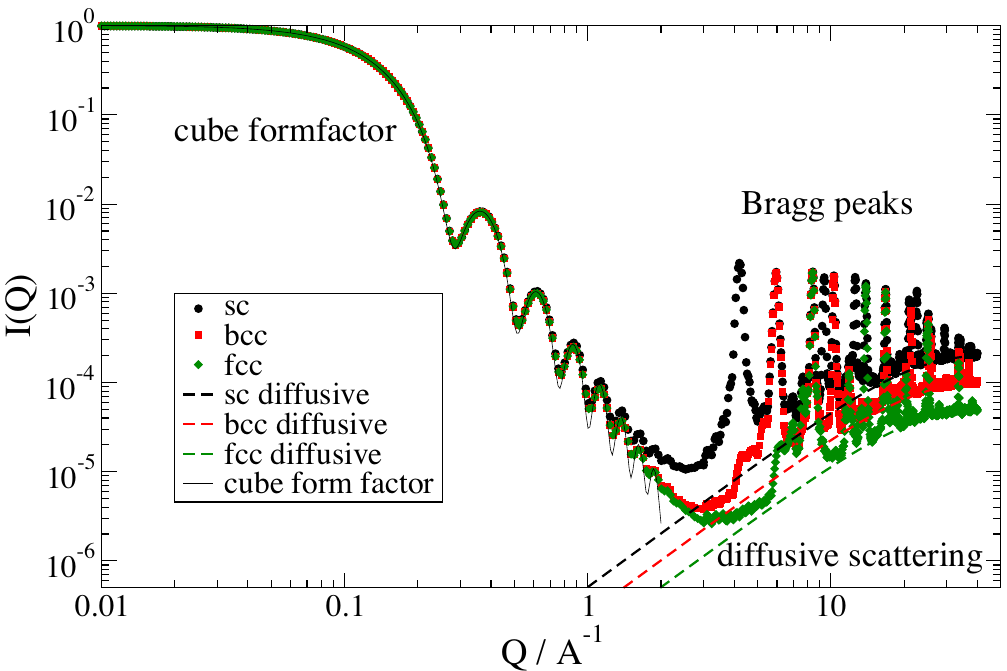
Fig 5. Simple cubic (sc), body centered cubic (bcc) and face centered cubic (fcc) lattices in a cubic cluster shape. At low Q the analytic form factor of a cube is shown. The explicit calculation shows a reduction of the peak intensities due to the Debye- Waller factor, which additional causes diffusive scattering at higher Q. Because of the incomplete lattice planes the extinction rules of fcc and bcc lattice are not fulfilled completely resulting in additional small peaks at forbidden peak positions below the first regular Bragg peak. Calculated within example 18 in